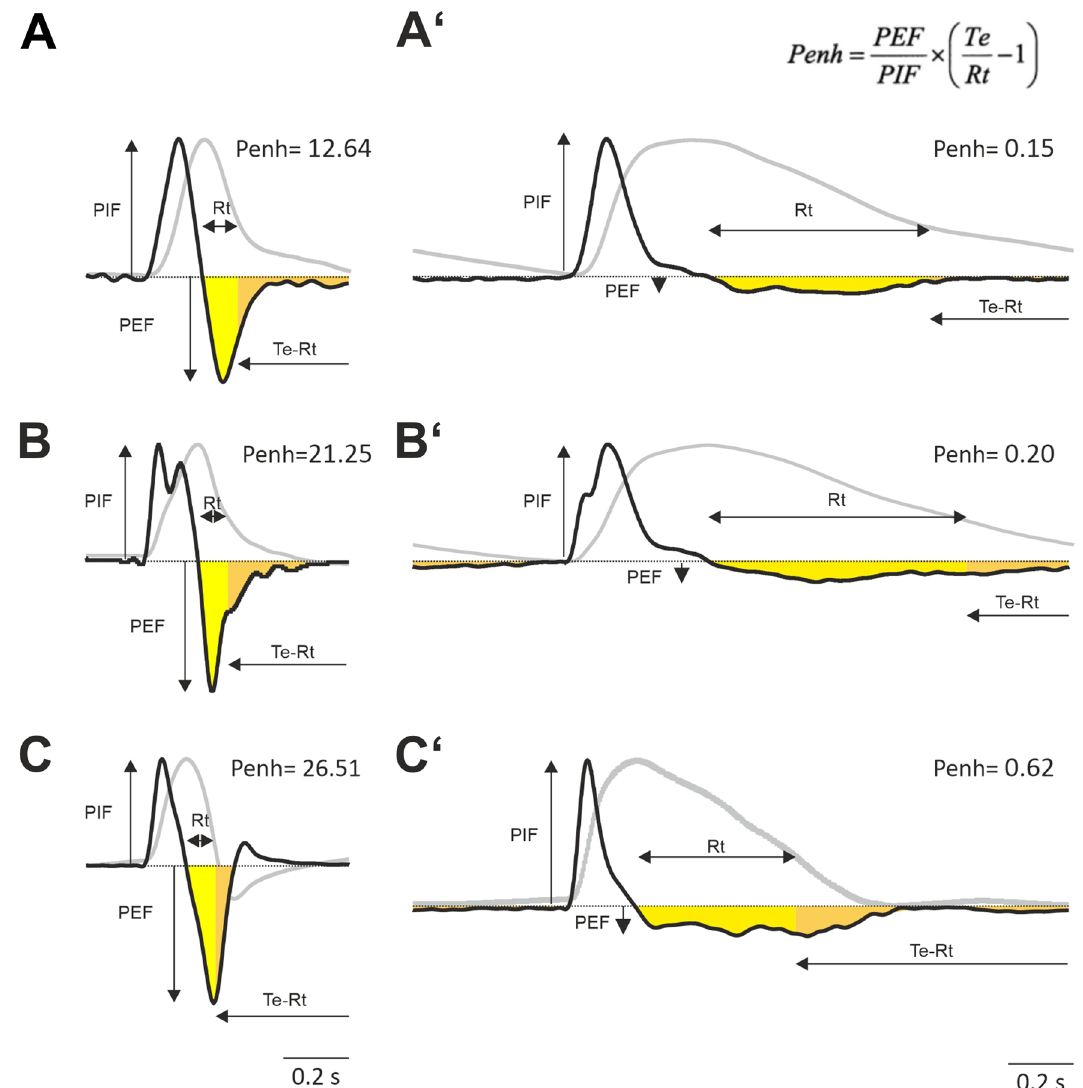
Figure 6. Analysis of the enhanced pause (Penh) parameter. ( A ) Left traces show the flow signal form an ALM (heater on) with no additional resistance (T i 50 ms and T E 100 ms). The gray curve represents the integral of the flow, which equals volume (normalized). ( A’ ) same ALM as ( A ) with T E changed to 800 ms. ( B , B’ ) Measurements as in ( A , A’ ) with a 20G resistance. ( C , C’ ) Measurements as in ( A , A’ ) with a 27G resistance. The parameters for Penh are peak inspiratory flow (PIF); peak expiratory flow (PEF); expiratory time (Te), which equals the interval between peak of volume trace and beginning of next inspiration; time to expire 65% of the volume (Rt). In all experiments the respiratory rate was 0.5 s -1 ; traces are average data from 5 to 10 respiratory